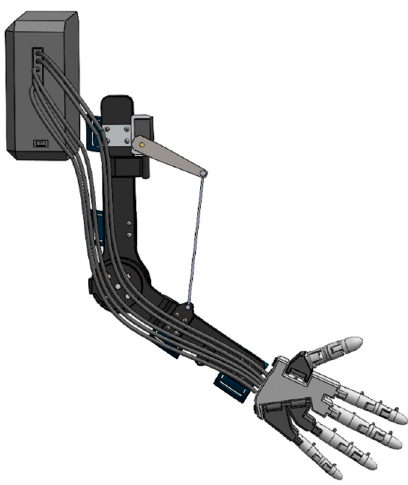
Figure 9. Side view of the exoskeleton.